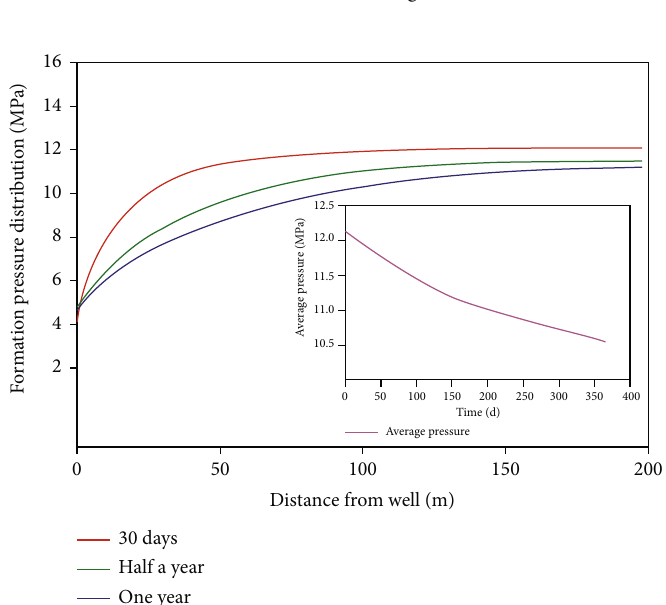
Figure 12: The distributions of pressure and average formation pressure at di ff erent